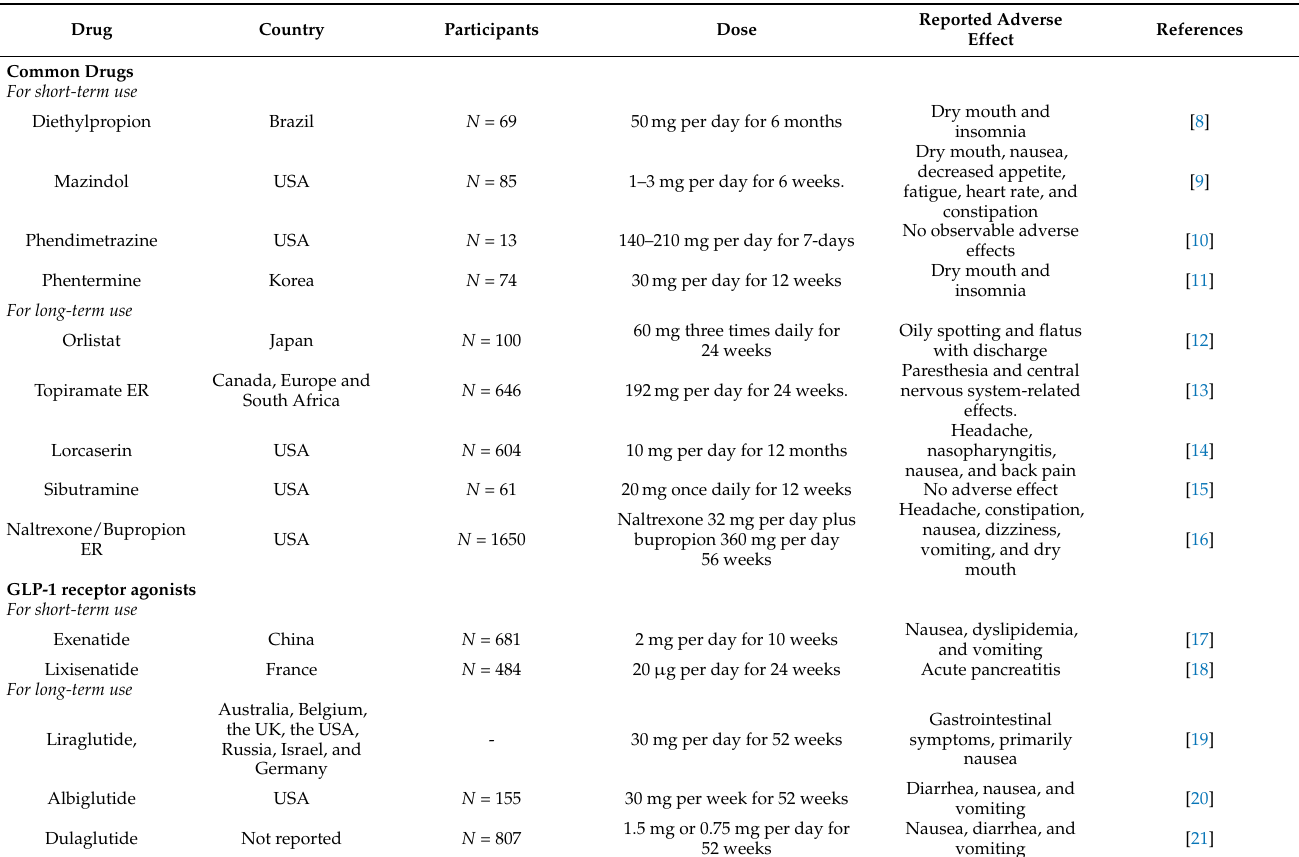
Table 1. Safety of anti-obesity drugs in clinical